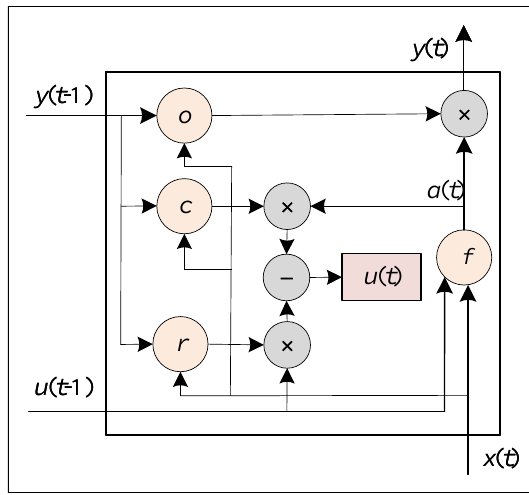
Figure 1. The recurrent − like NSNP neuron